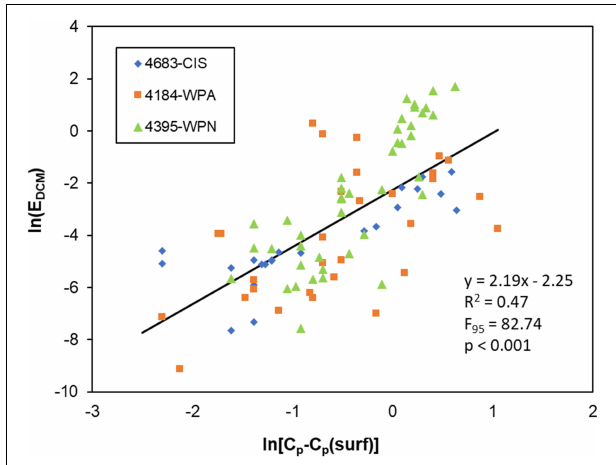
FIGURE 5 | Comparison in log-space between E DCM (irradiance at the base of the mixed layer as Equation 2) and a measure of phytoplankton carbon biomass in the deep chlorophyll maximum (DCM) from profiling floats (C p -C p (surf): see text for